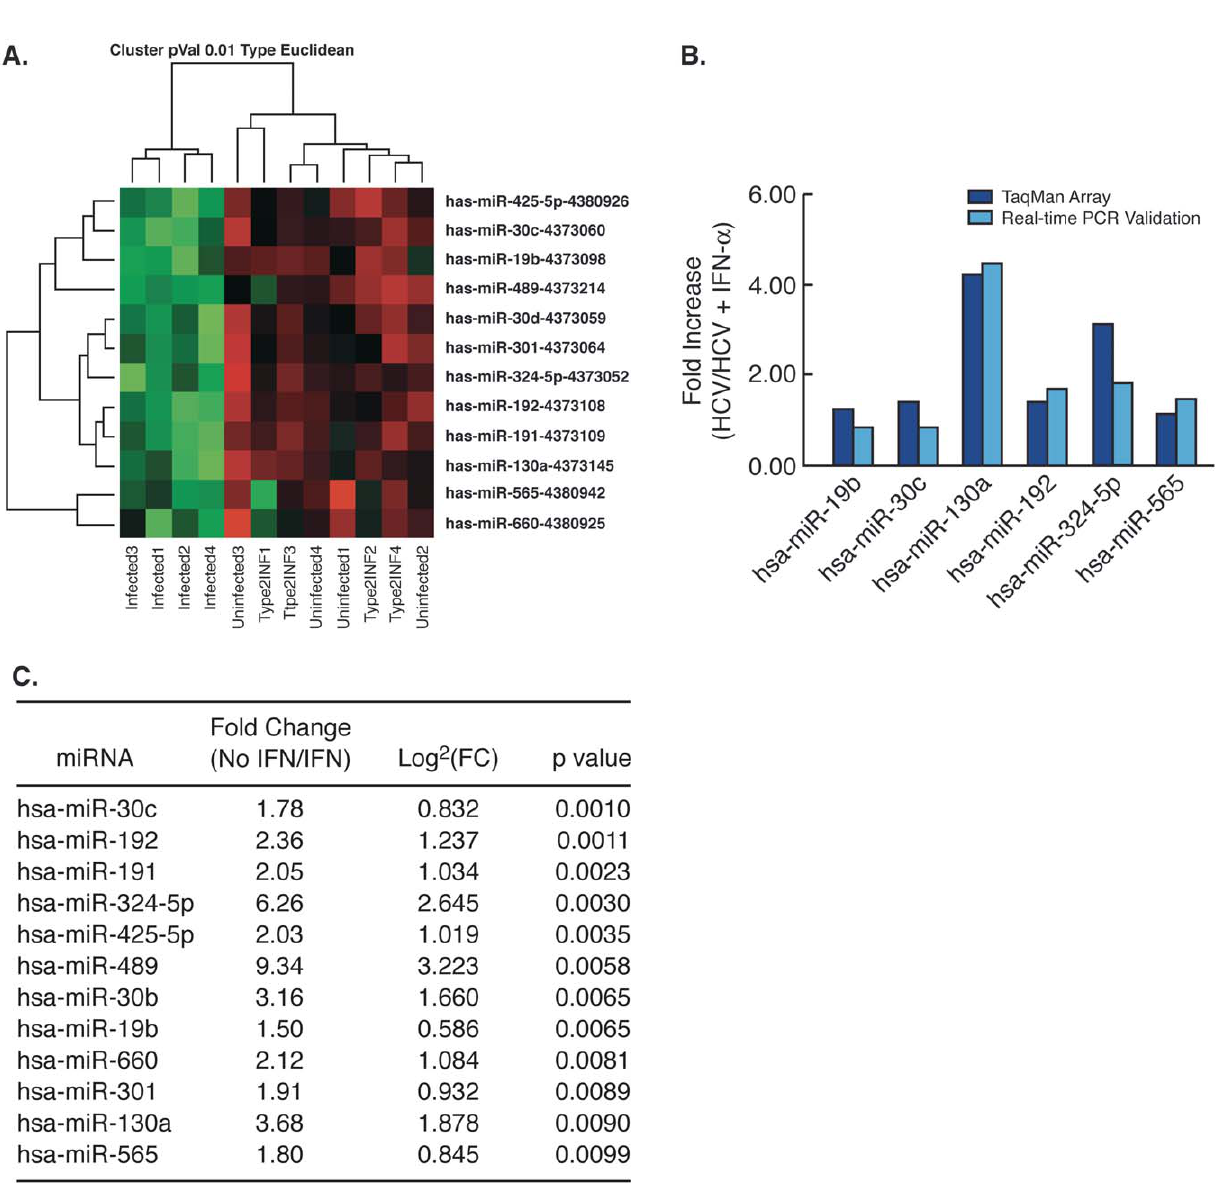
Figure 3. MiRNA expression and validation in HCV-infected Huh7.5 cells treated with IFN- a . (A) Heat map of differentially expressed in uninfected, HCV-infected, and HCV-infected with IFN- a , Huh7.5 cells. Twelve miRNAs were differentially expressed in response to IFN- a at a p value # 0.01. (B) Q-RTPCR validation of 7 of the 12 differentially regulated miRNAs. (C) Specific fold changes in differentially expressed miRNAs ranked by p-